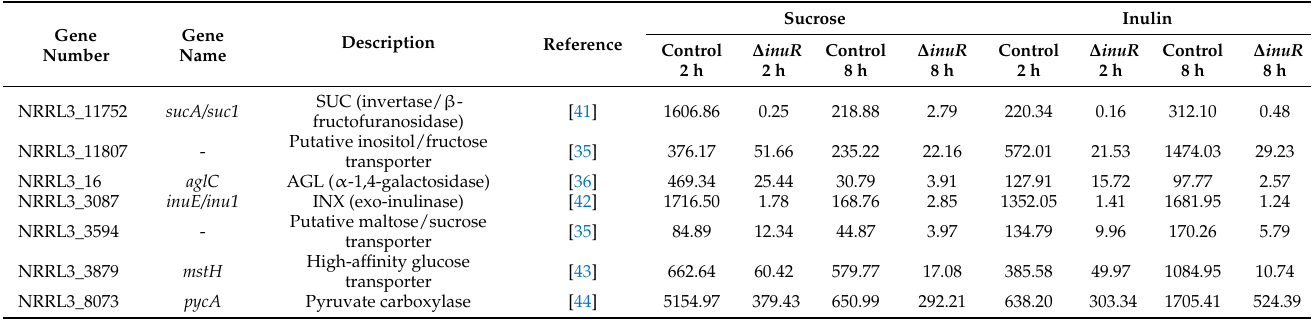
Table 1. Downregulated genes in the A. niger ∆ inuR strain compared to the control in liquid media. The genes included in this table were downregulated in both media containing 1% sucrose or 1% inulin after 2 and 8 h of growth. Gene expression is represented as FPKM